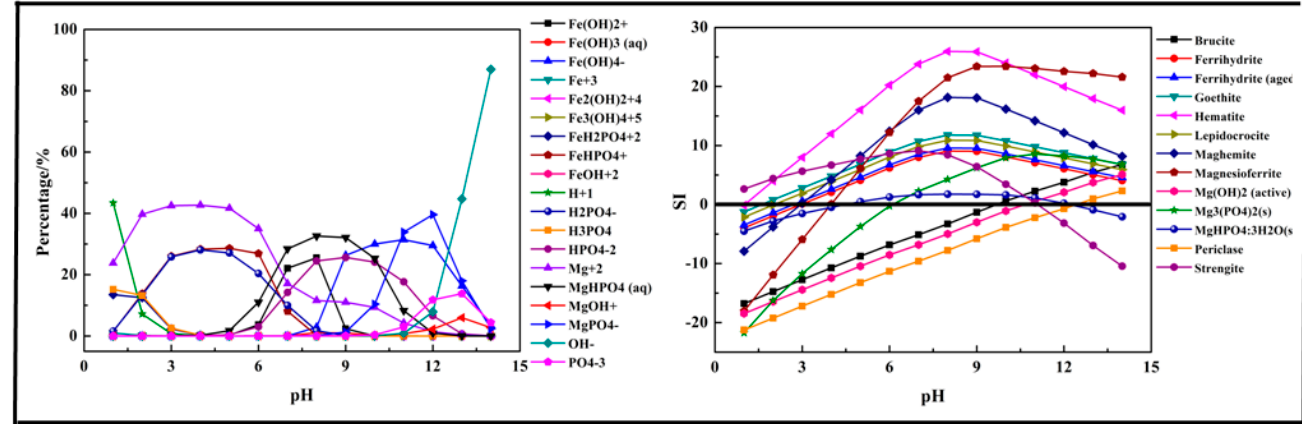
Figure 7. Percentage of species in the Fe-Mg-P-H 2 O system at 298 K at ranged pH ((P) = 0.01 mol/L, (Fe 3+ ) = 0.003 mol/L, (Mg 2+ ) = 0.0075 mol/L).